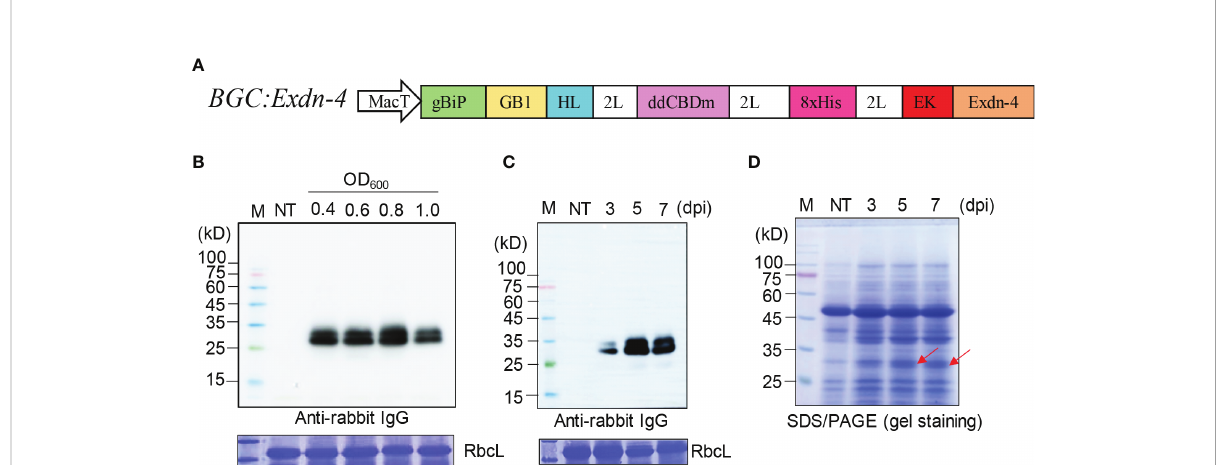
FIGURE 1 A recombinant gene containing Exdn-4 is expressed at high levels in N. benthamiana. (A) Schematic presentation of the recombinant construct. BGC : Exdn-4 contains various domains for high-level expression. gBiP, a genomic DNA fragment of Arabidopsis BiP1 encoding the signal peptide for ER targeting; GB1, B1 domain of streptococcal G protein; HL, a helical wheel-forming linker; 2L, 2 copies of a fl exible linker GGGS; ddCBDm, two copies of CBD1 with a mutation of tyrosine 34 to histidine; 8xHis, eight His residues; EK, enterokinase cleavage site; MacT, MacT promoter. (B, C) Optimization for the expression of recombinant construct. (B) N. benthamiana leaves were in fi ltrated with different Agrobacterium concentrations (0.4, 0.6, 0.8, and 1.0 of OD 600 ) and leaf tissues were harvested at 5 dpi. (C) Plants in fi ltrated with Agrobacterium at 0.8 of OD 600 were grown for 3, 5, or 7 days after in fi ltration. Total protein extracts from leaf tissues were separated by SDS/PAGE and analyzed by Western blotting using HRP-conjugated anti-rabbit IgG antibody. M, protein size standard; NT, non-transformed wild-type plants. RbcL stained with CBB, a loading control. (D) SDS/PAGE analysis for the expression of BGC : Exdn-4. Total soluble protein extracts (10 m g) were separated by SDS/PAGE and the gel was stained with CBB to detect the protein band of BGC : Exdn-4. Arrows, the expected size of BGC : Exdn-4; Lane M, protein size standard; NT, non-transformed wild-type N. benthamiana